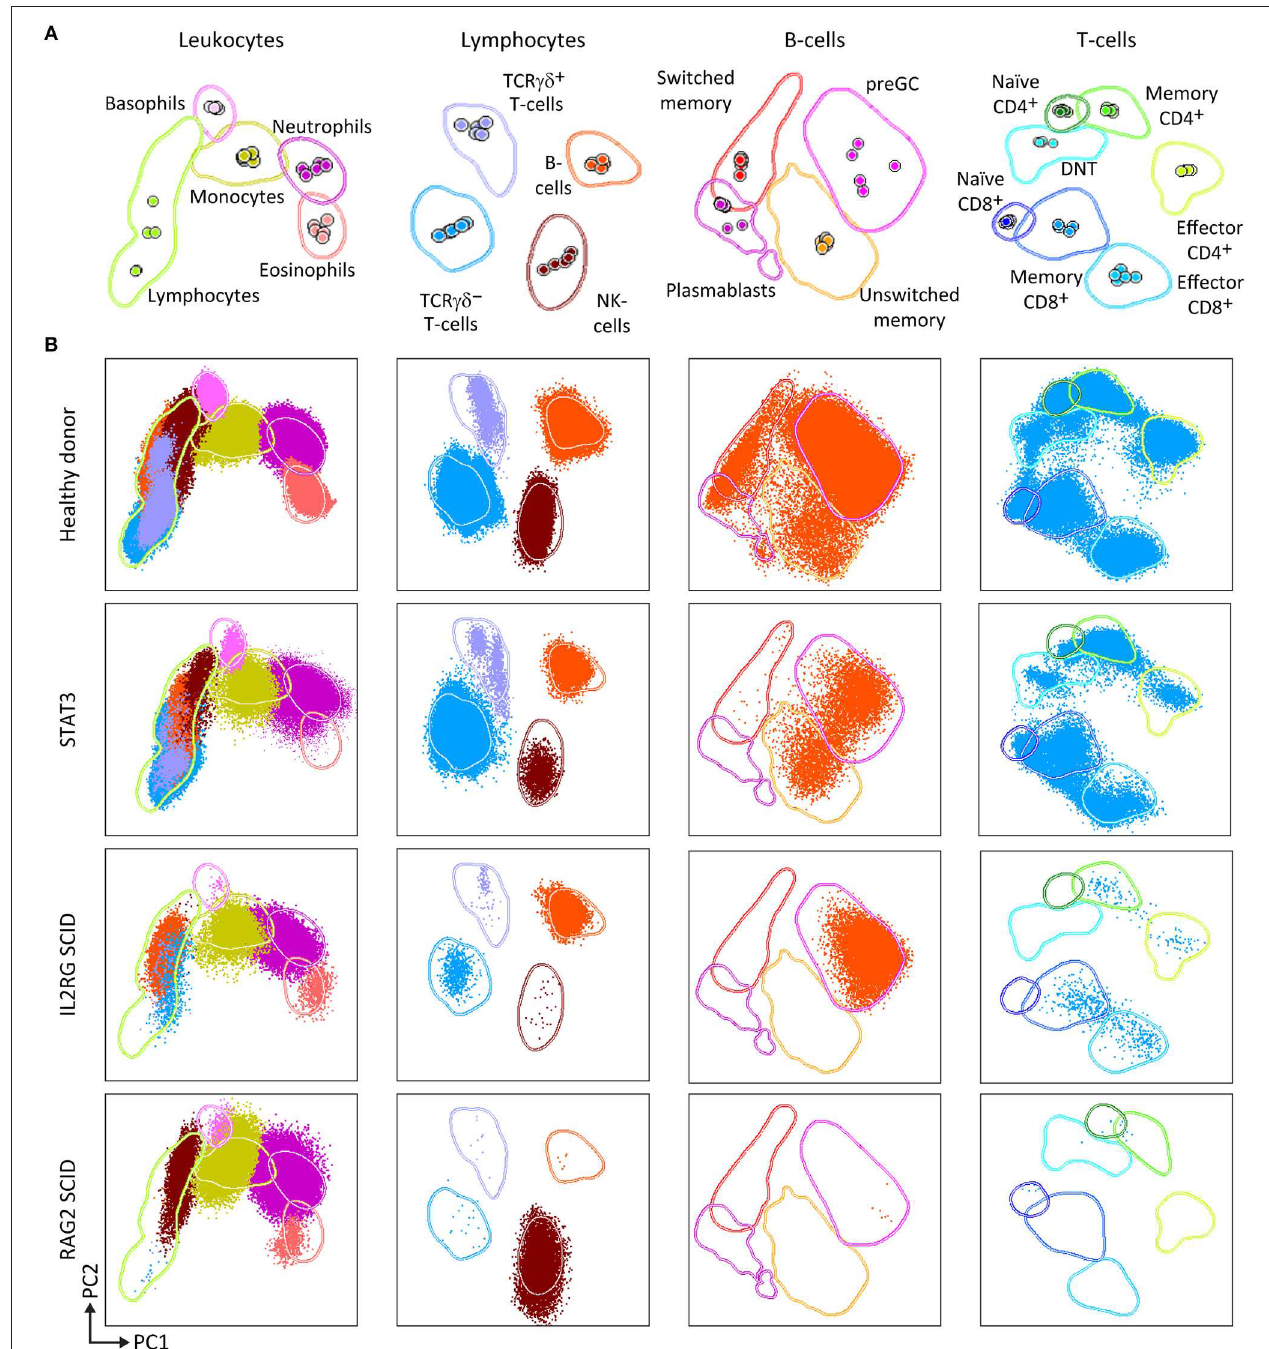
FIGURE 3 | PCA representation of PIDOT results, showing the distinct blood leukocyte subsets in the reference data file and supervised analysis of blood samples from a healthy donor and three different PID patients. (A) Reference principal component analysis. PCA1 vs. PCA2 representation was generated from five healthy donors data files, analyzed with the EuroFlow PIDOT. (B) Different patient samples were analyzed against the healthy donor PCA reference. Blood samples from a healthy donor, a patient with mutated STAT3, a SCID patient with IL2 receptor gamma chain (IL2RG) deficiency, and a SCID patient with recombination activating gene 2 (RAG2) deficiency were stained and acquired under identical/comparable conditions. The STAT3 deficient patient shows the typical pattern of reduced naïve T-cells, virtually no IgH-class switched B-cells, and no eosinophils. The IL2RG deficient SCID patient has virtually no T-cells, particularly no naïve T-cells ( < 1 cell/ µ L; see Figure 1B ), B-cells are present, but no memory B-cells or plasmablasts, and NK-cells are virtually absent. The RAG2 deficient SCID patient has no B-cells and no T-cells, while NK-cells are present in normal numbers. DNT, double negative T-cells, negative for CD4 and CD8, but positive for CD3.